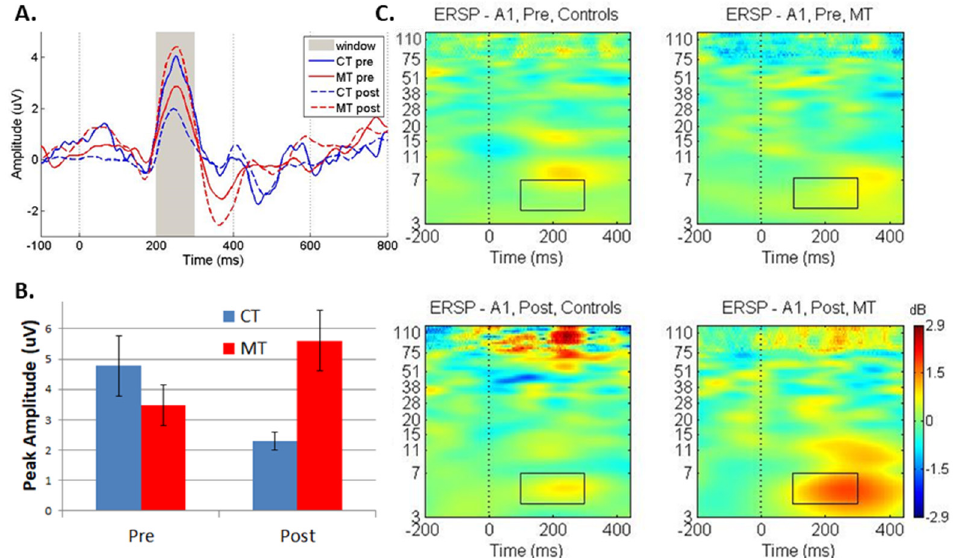
Figure 2. ( A ) The group averaged ERP waveform from the midline fronto-central averaged EEG elec-